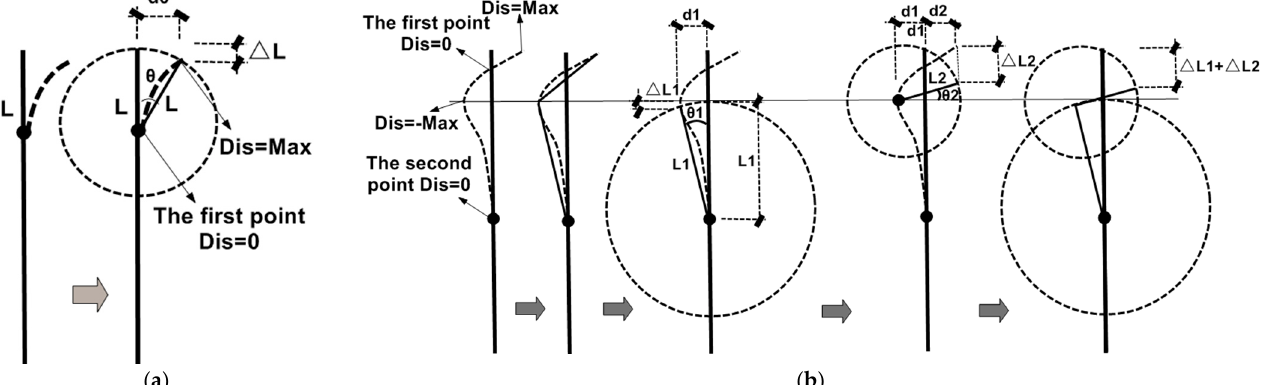
Figure 6. Displacement correction method of batter piles ( a ) No.1 and ( b ) No.2.